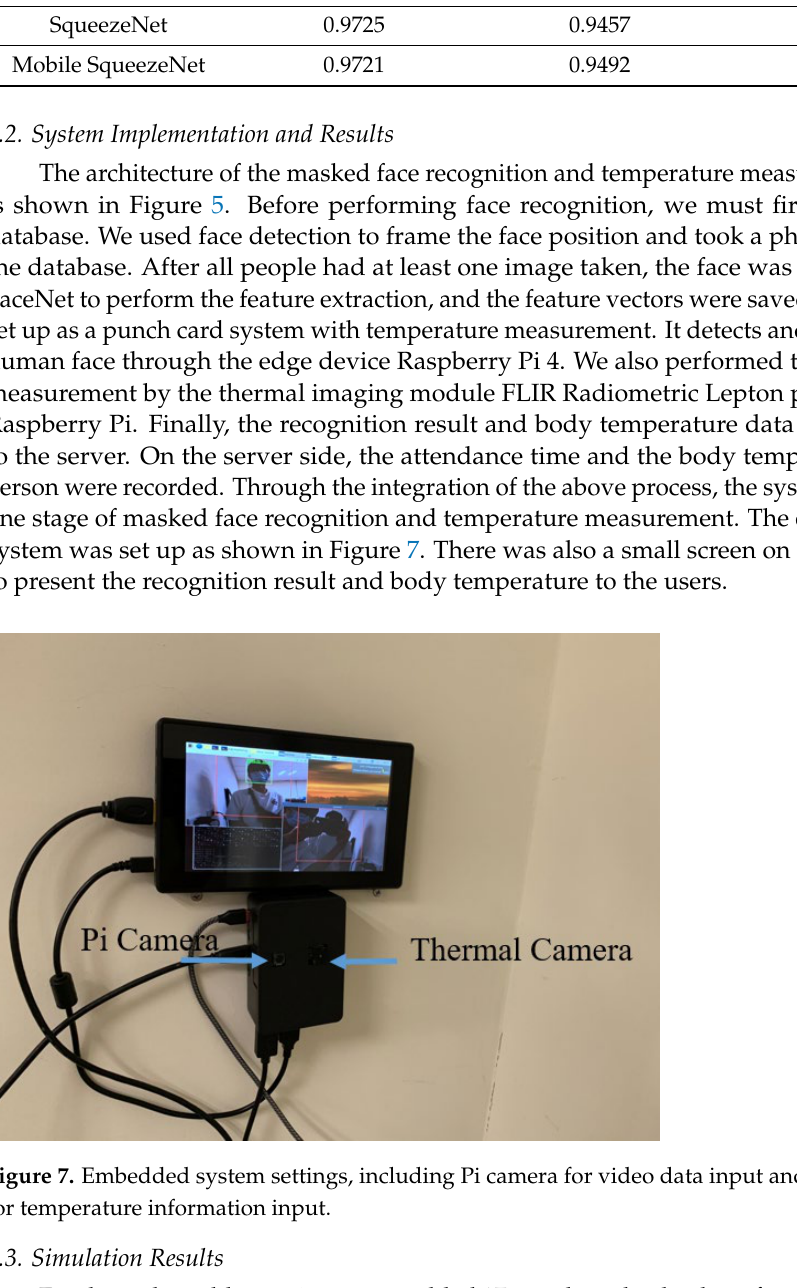
Table 6. The accuracy of face recognition without and with a mask in the real world with simu- lated VGGFACE2.